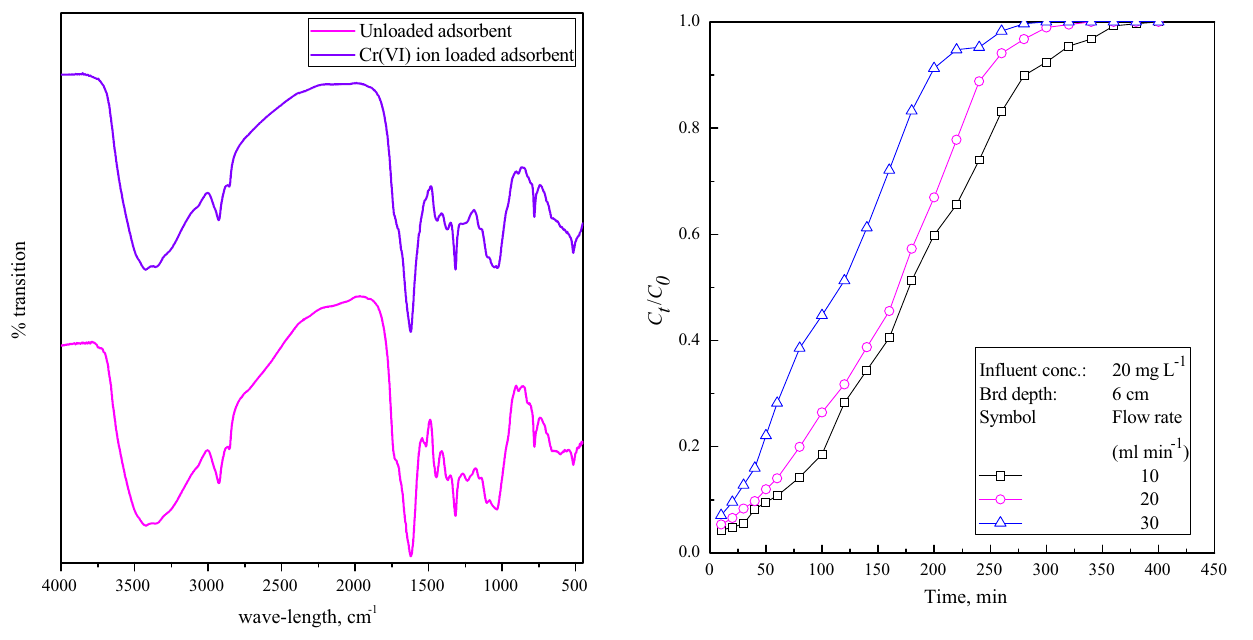
Fig. 3 FTIR plot for Cr(VI) ion adsorption using guava leaves